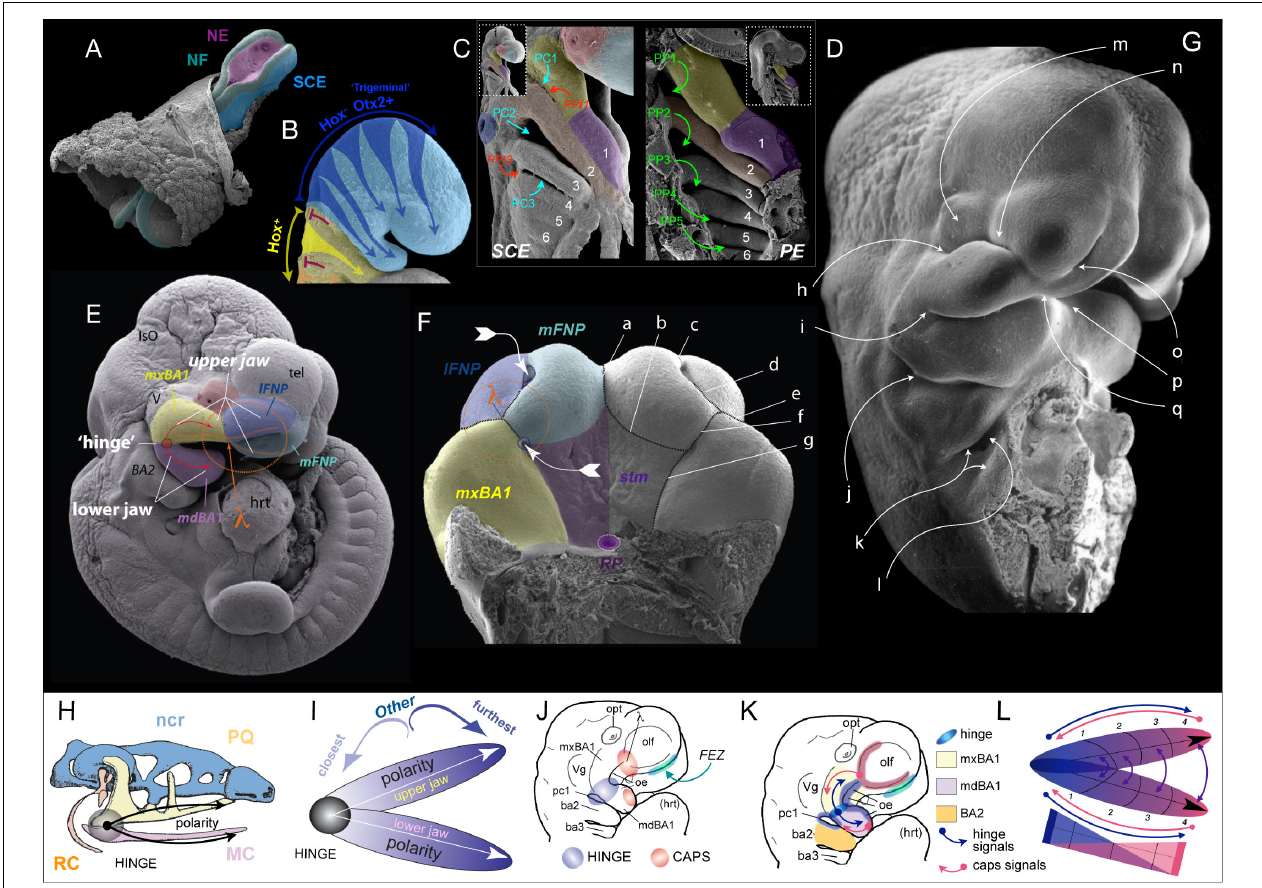
FIGURE 1 | Early craniofacial patterning and development. (A–G) Scanning electron micrographs of shark (A,C,D) and mouse (B,E–G) embryos. (A) Nuerulation in a shark. NF, neural fold; NE, neurectoderm; SCE, surface cephalic ectoderm. (B) Fungible, trigeminal cranial neural crest (CNC) fills BA1 and the FNP. E9.25 mouse embryo. Hox − : blue. Hox + : yellow arrows entering BA2 from R4, orange entering BA3 from R6. Red T-bars indicate the apoptotic culling of R3 and R5 CNC. (C,D) SCE and PE in the BA of a hemisected shark embryo. 1–6, BA number. PC1–3, pharyngeal clefts 1–3 (SCE). PP1–5, pharyngeal pouches 1–5 (PE). PPt1/3, pharyngeal plates. lavender, mdBA1; yellow, mxBA1; red, optic primordia; light blue, FNP; dark blue, otic pit; orange, BA2. (E) E10.5 mouse embryo showing the topography of the craniofacial primordia, the hinge region and λ (the lambdoidal junction). IsO, isthmic organizer; tel, telencephalon; hrt, heart; lFNP, lateral frontonasal process; mFNP, medial frontonasal process; V, trigeminal ganglion. Colour as above. (F) E11.5 mouse embryo (with the lower jaw primordia removed) showing the embryonic primordia of the λ and correlated anatomical boundaries. The converging white arrows indicate the invaginating external nares and internal (primary) choanae whose infoldings must unite and perforate to form a nasal cavity (fossa) that communicates directly with the lower respiratory system via a nasopharynx. a , internasal line (frontal groove); b , naso-stomodeal line; c , dorsal intranasal line; d , ventral intranasal line (nasal fin); e , nasolacrimal line (groove); f , oronasal groove (medial-choanal line); g , stomodeo-palatal line. (G) E11.5 mouse embryo highlighting positions of epithelial-epithelial apposition. h , ridge of optical furrow from which the lower eyelid will sprout; i , mxBA1-mdBA1 fusion at the oral commissure; j , first pharyngeal cleft and plate; k , opercular ridge of BA2 and epipericardial ridge with which it fuses; l , cervical sinus; m , recently pinched off lens; n , nasolacrimal groove; o , nasal fin; p , mentum (mdBa1-mdBA1); q , mFNP-mxBA1. (H) Schematic of prototypical vertebrate chondrocranium and the inherent polarity of it jaws. ncr, neurocranium; RC, Reichert’s cartilage; HINGE, circle at articulation; MC, Meckel’s cartilage; PQ, palatoquadrate cartilage. (I) Schema of the inherent polarity of appositional jaws. (J) Orientation of hinge and caps topography on an E10 mouse embryo. opt, optic primordia; Vg, trigeminal ganglion; FEZ, facial (frontonasal) ectodermal zone which helps integrate the frontonasal midline; oe, oral ectoderm. (K) Topography of epithelial signaling from the hinge (blue) and caps (red) signaling centres. (L) Modularity due to polarity in jaw development. Apposing gradients of signaling information create modules (here, 1–4) within the developing jaw